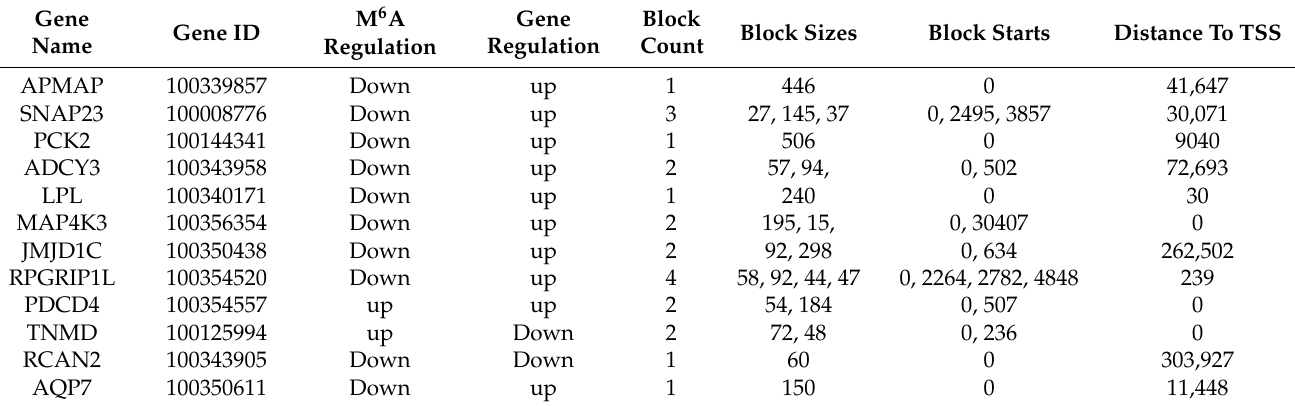
Table 5. Candidate m 6 A-modified genes related to fat deposition and difference peaks.